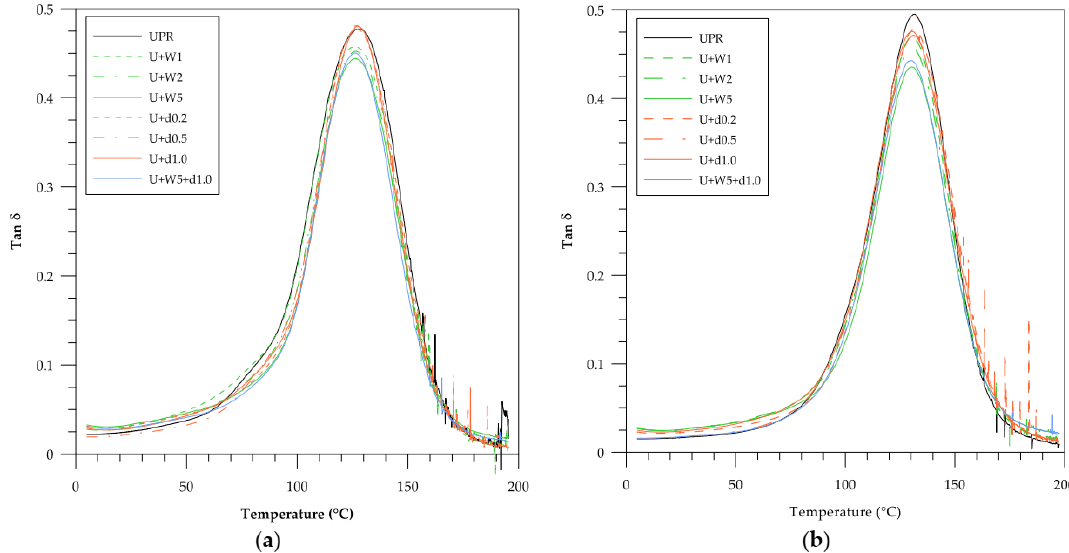
Figure 5. Mechanical loss factor (tan δ max ) vs. temperature for pure UPR and green composites with WF and dba. ( a ) Before the accelerated aging test and ( b ) after the accelerated aging